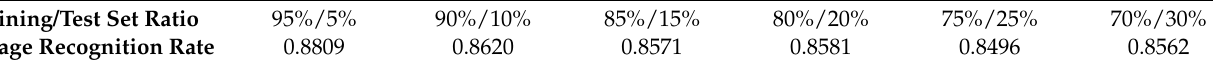
Figure 18. The recognition rate of lower-limb EMG signal to movements. Table 7. Recognition rate in 4 movements under different test set/verification set ratios.